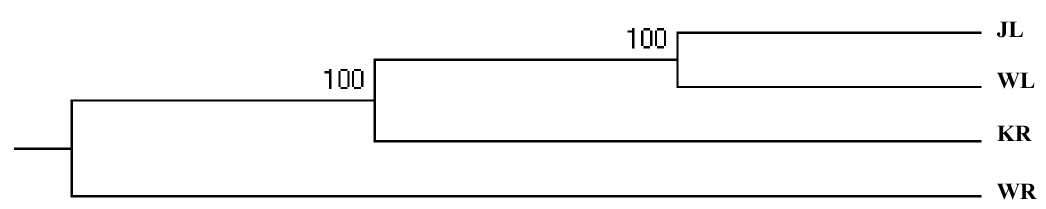
* Indicates a significant difference ( p < 0.05).